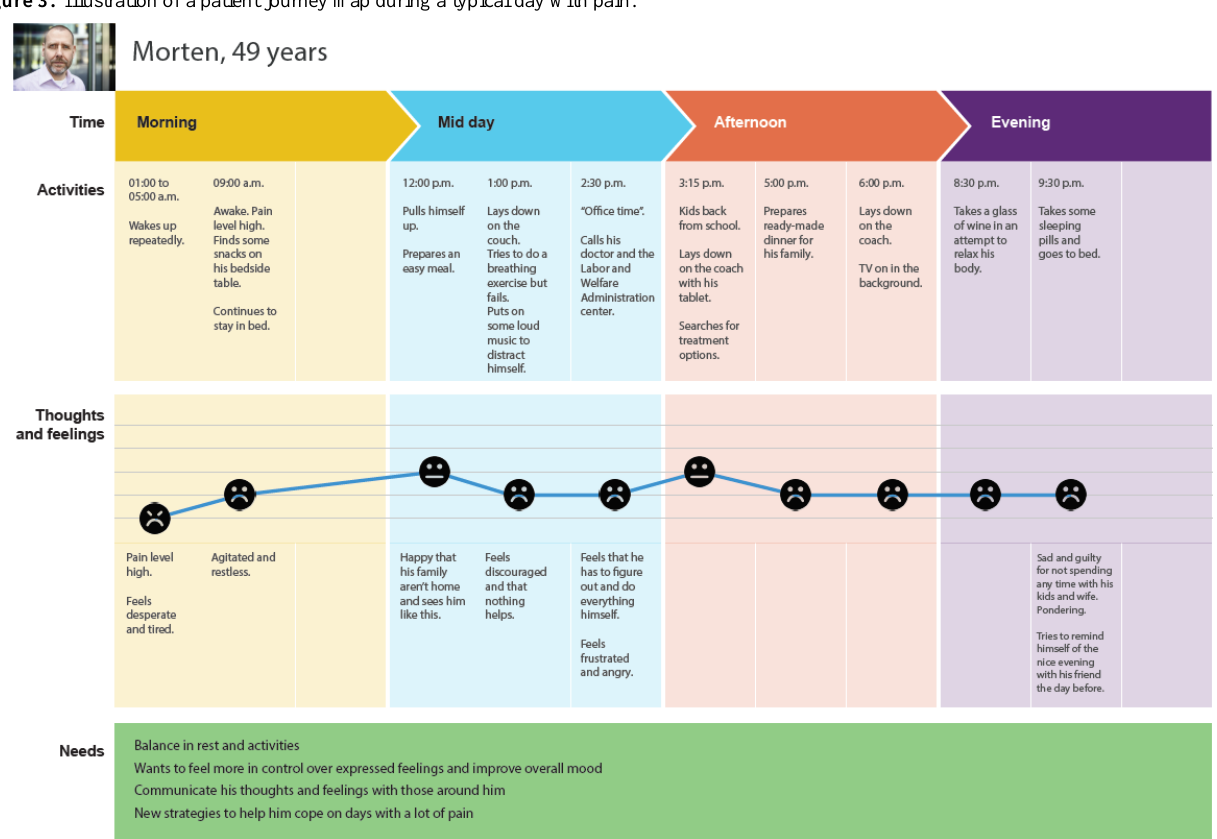
Figure 3. Illustration of a patient journey map during a typical day with